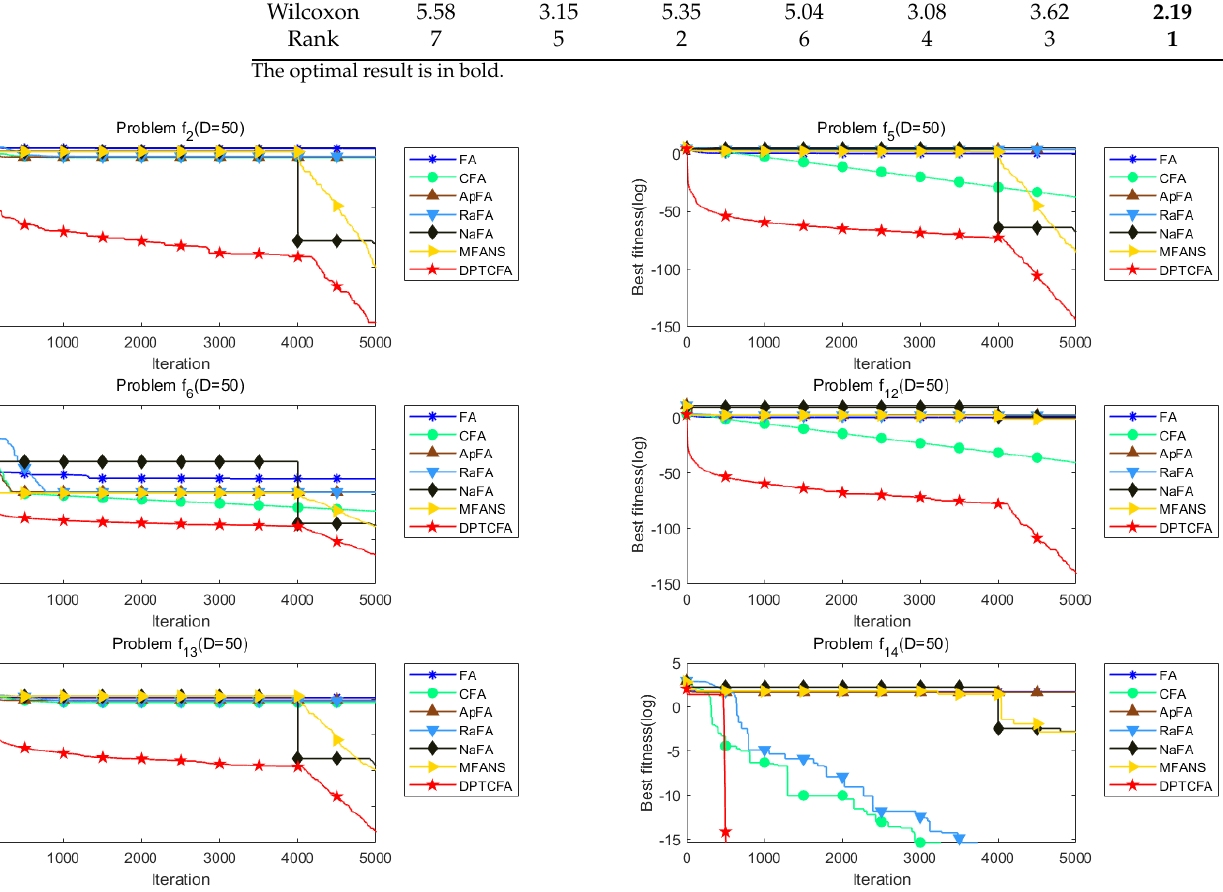
Figure 10. Search curves of DPTCFA and other FA variants ( D =